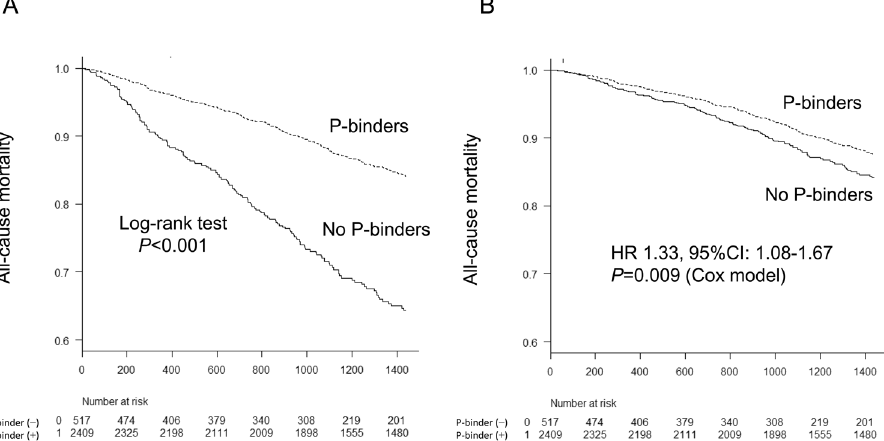
Figure 3. Kaplan-Meier analysis for the all-cause mortality between phosphate-binder users and non-users. ( A ) Non-adjusted curve. ( B ) Multivariable-adjusted curve. Log-rank test was used to compare the survival curve between the two groups in non-adjusted curve. Adjustment using Cox proportional hazard model was performed for baseline characteristics (age, sex, presence of diabetes mellitus and comorbidity, dialysis vintage, dialysis time per session, Kt/V for urea, normalized protein catabolic rate, body mass index, cardiothoracic ratio, systolic blood pressure, blood hemoglobin level, serum levels of urea nitrogen, creatinine, albumin, total cholesterol, C-reactive protein, corrected calcium, phosphate, parathyroid hormone, alkaline phosphatase, and use of erythropoiesis stimulating agents, anti-hypertensives, and vitamin D receptor activators. The relative hazards risk and 95%Ci in patients without P-binders compared with those with P-binders were described in the figure. A two-tailed P -value < 0.05 was considered to be statistically significant. Abbreviations: CI, confidence interval; HR, hazard ratio; P,